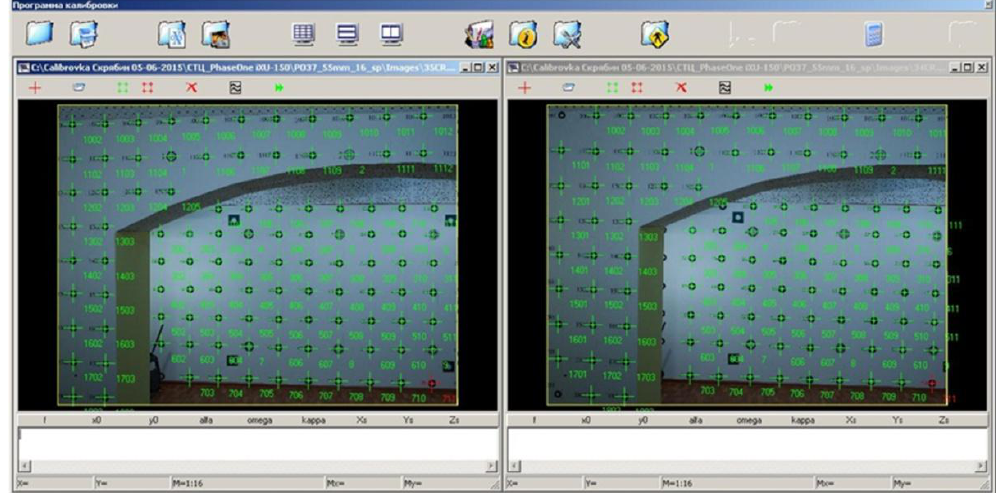
Figure 1. Spatial test-object for laboratory camera